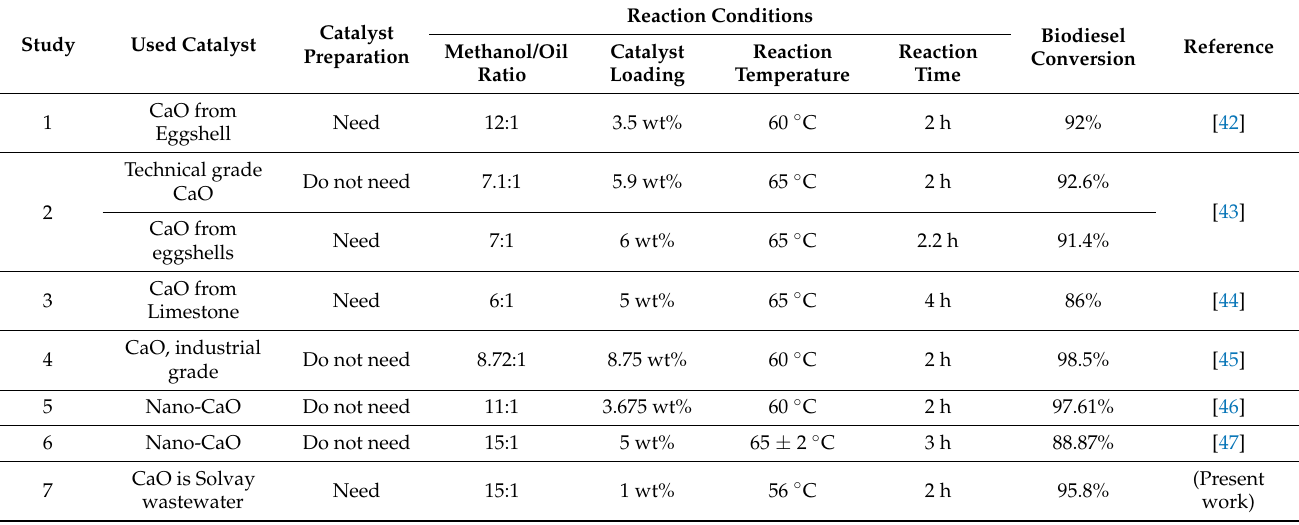
Table 15. Comparison of the results of this research and the previous